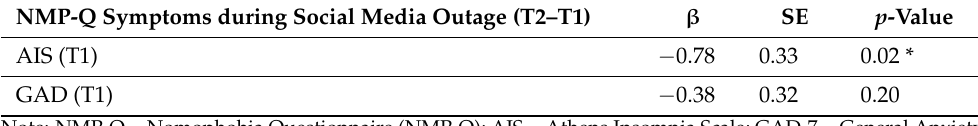
Table 4. The association between AIS and GAD-7 scores at baseline (T1) with the change in NMP-Q symptoms during the social media outage